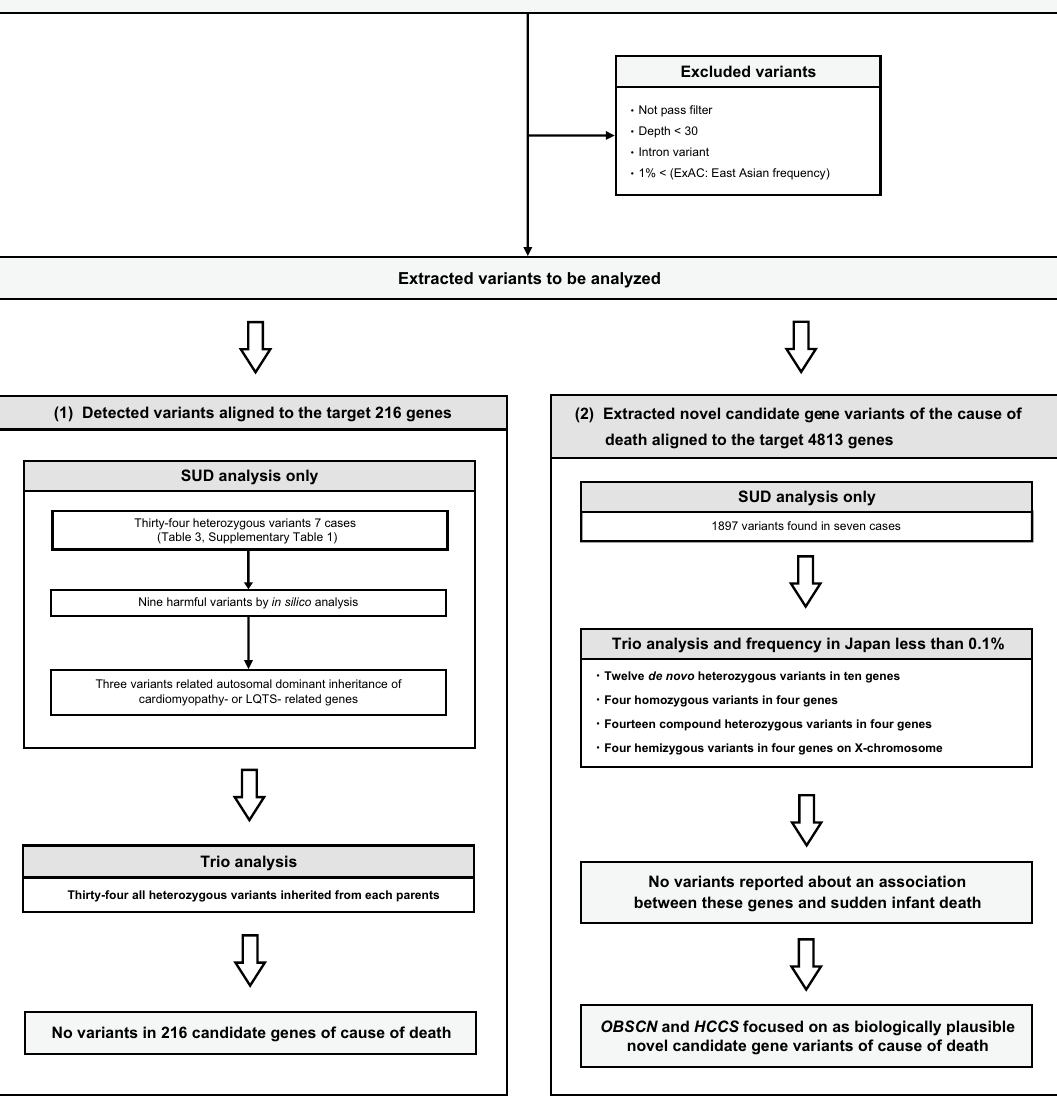
Figure 2. Flowchart of the selection process showing candidate genes for cause of death in this study. The frequency of variants in Japanese people was based on ToMMo and HGVD data. ( a ) The target 216 genes are listed in Table 2. ( b ) All genes included in the TruSight One panel are shown in Supplementary Text 1. Abbreviations: SUD: sudden unexpected